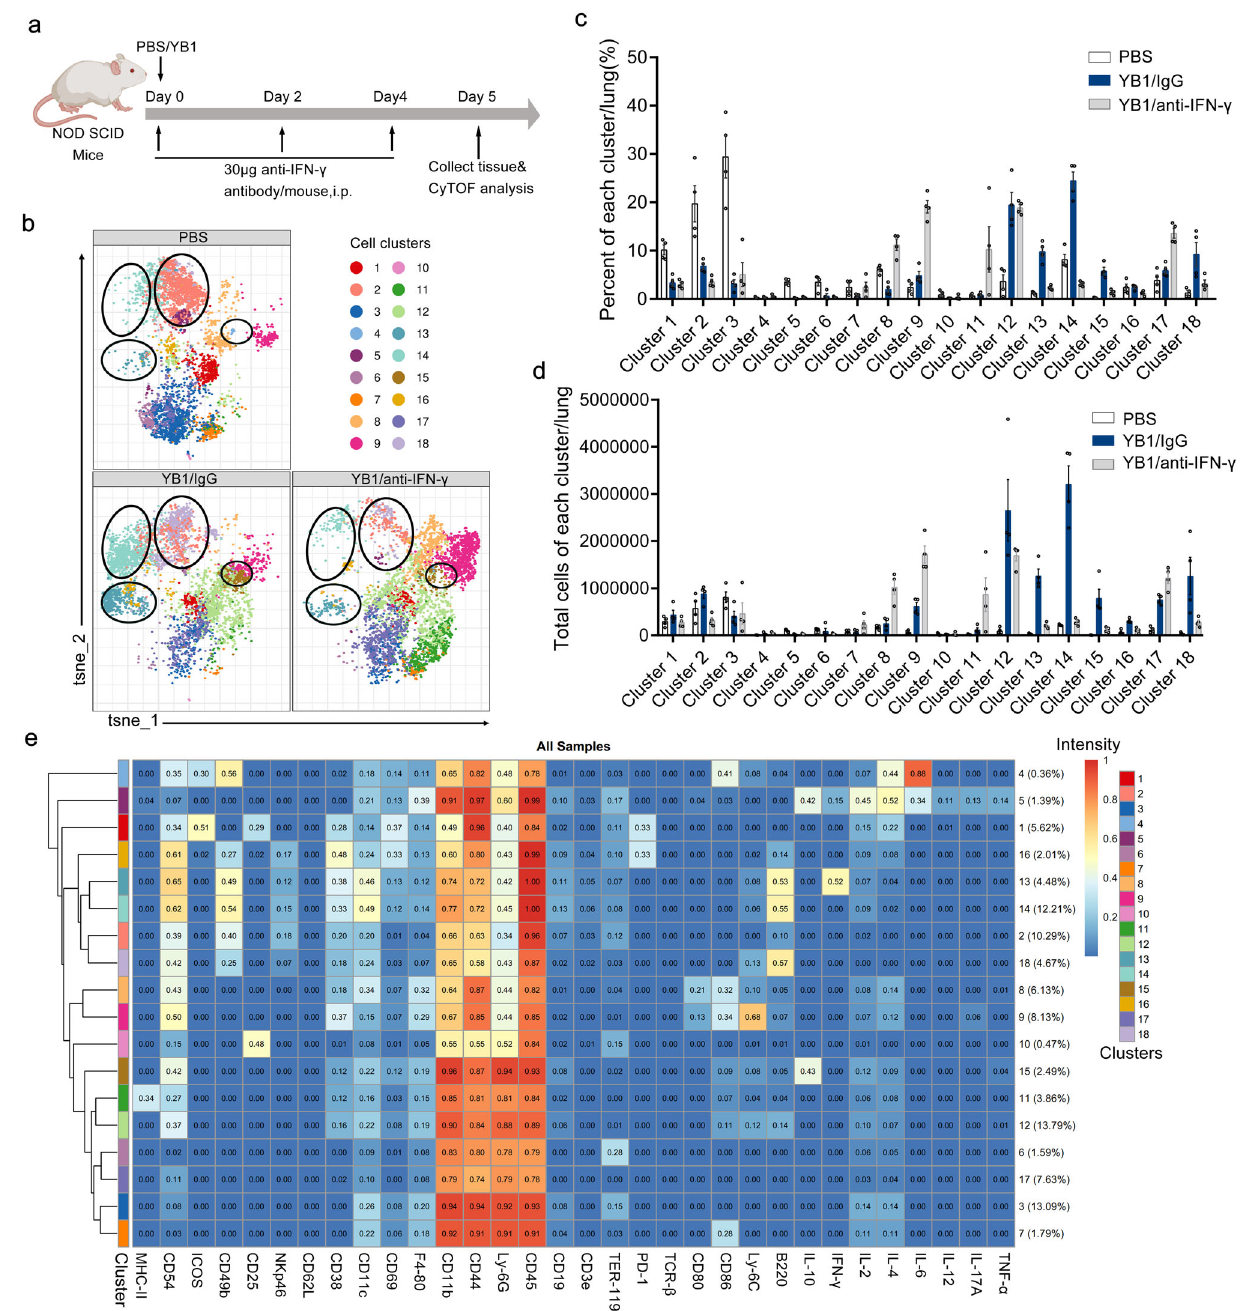
Fig. 5 IFN- γ promotes the accumulation of neutrophils and NK cells in the lung environment of NOD SCID mice after Salmonella YB1 treatment. a Mice treatment timeline for CyTOF analysis. NOD SCID mice were divided into three groups treated with PBS, YB1 (YB1/IgG), or YB1 plus IFN- γ depletion antibody (YB1/anti-IFN- γ ), respectively. All mice were killed on day 5 and lung-in fi ltrating immune cells were isolated and prepared for CyTOF analysis. b Representative t-SNE pro fi le from each group of mice. Immune cell clusters 13, 14, 15, and 18 are highlighted by circles. c Percentage of each immune cell cluster per lung across samples ( n = 4 per group). d Total cell number of each immune cell cluster per lung across samples ( n = 4 per group). Immune cell clusters 13, 14, 15, and 18 were upregulated in the YB1 group compared to the other two control groups. c , d All data are presented as mean values ± SEM. e Characterization of each immune cell cluster. Based on the expressions of different phenotypic markers and cytokines, events acquired by CyTOF analysis of lung-in fi ltrating immune cells from NOD SCID mice with the three different treatments were merged for the t-SNE dimension reduction and PhenoGraph clustering analyses, and were divided into 18 immune cell clusters. Displayed one representative experiment of two independent experiments for all panels. Source data are provided as a Source Data fi